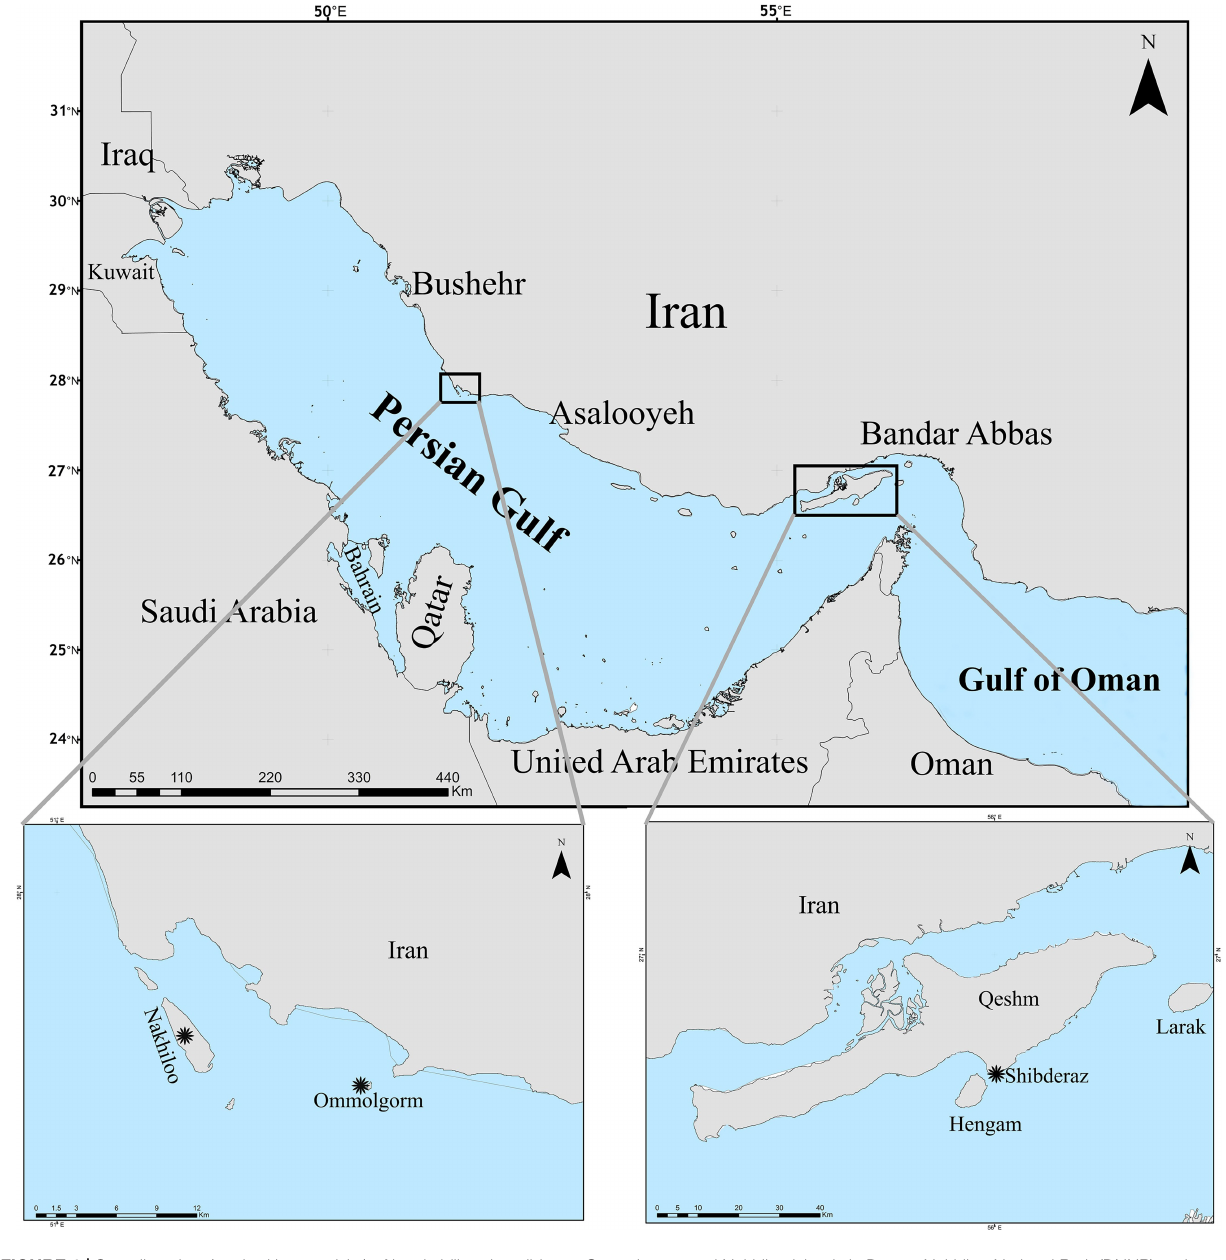
FIGURE 1 | Sampling sites (marked by asterisks) of hawksbill turtle epibionts, Ommolgorm, and Nakhiloo islands in Dayyer-Nakhiloo National Park (DNNP) and Shibderaz on Qeshm Island in the Iranian coasts of the Persian